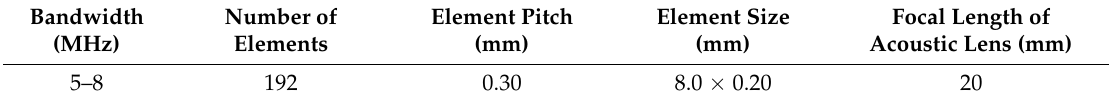
Table 1. Specifications of the array transducers used in MRI.